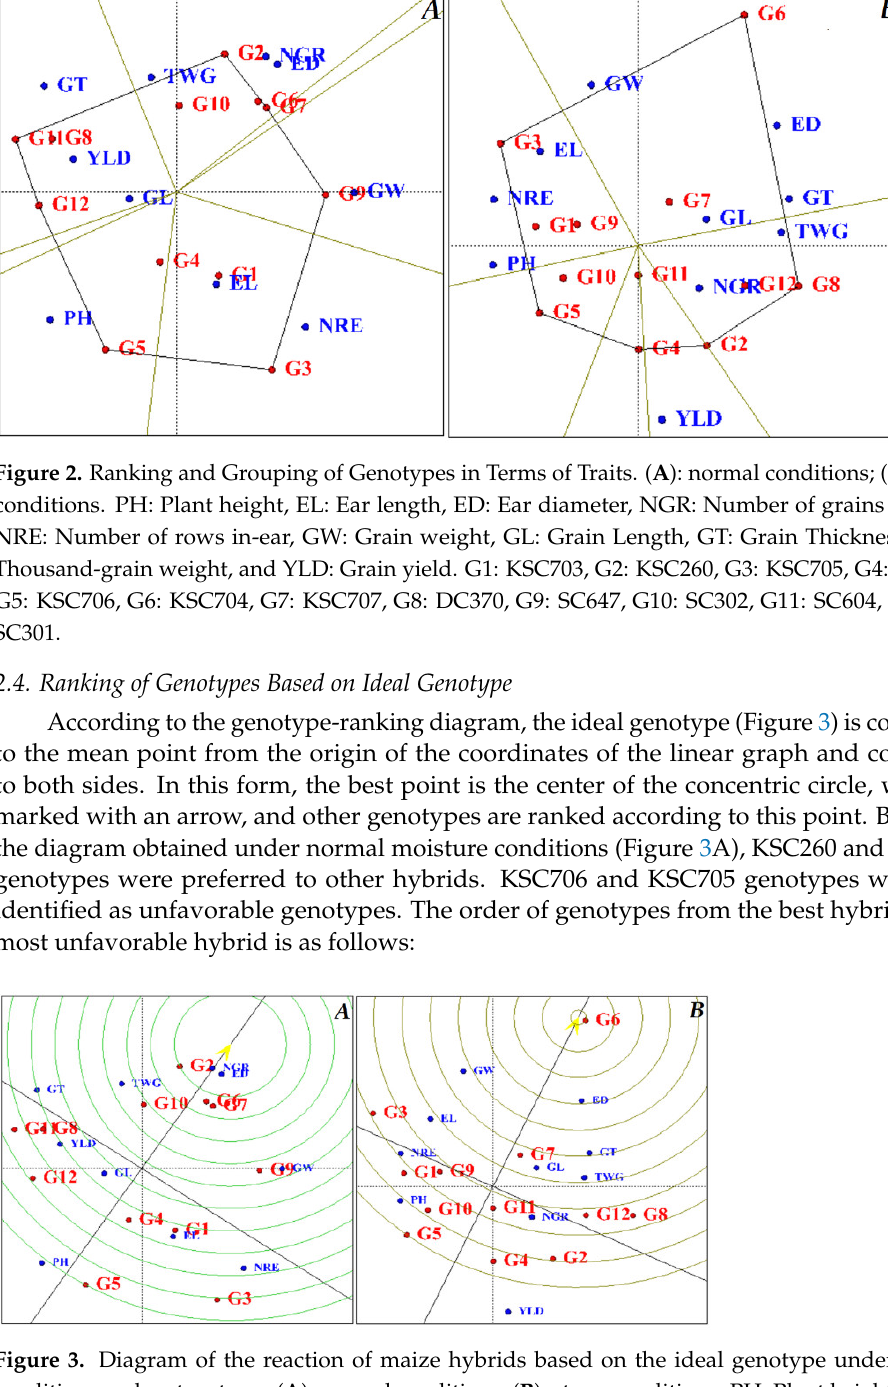
Figure 2. Ranking and Grouping of Genotypes in Terms of Traits. ( A ): normal conditions; ( B ): stress conditions. PH: Plant height, EL: Ear length, ED: Ear diameter, NGR: Number of grains in a row, NRE: Number of rows in-ear, GW: Grain weight, GL: Grain Length, GT: Grain Thickness, TWG: Thousand-grain weight, and YLD: Grain yield. G1: KSC703, G2: KSC260, G3: KSC705, G4: KSC400, G5: KSC706, G6: KSC704, G7: KSC707, G8: DC370, G9: SC647, G10: SC302, G11: SC604, and G12: